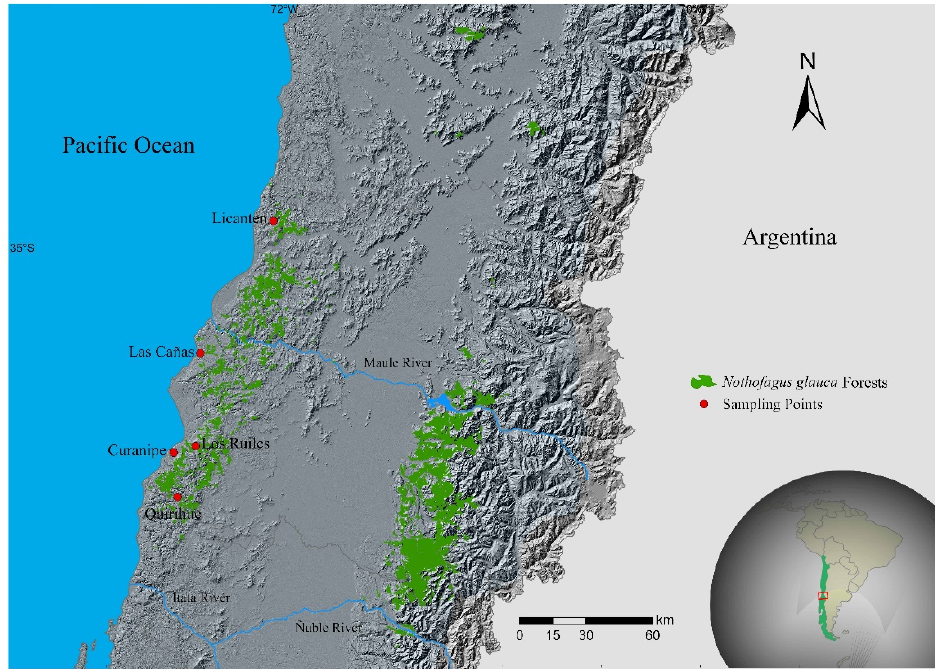
Figure 3. Seed provenances of Nothofagus glauca.